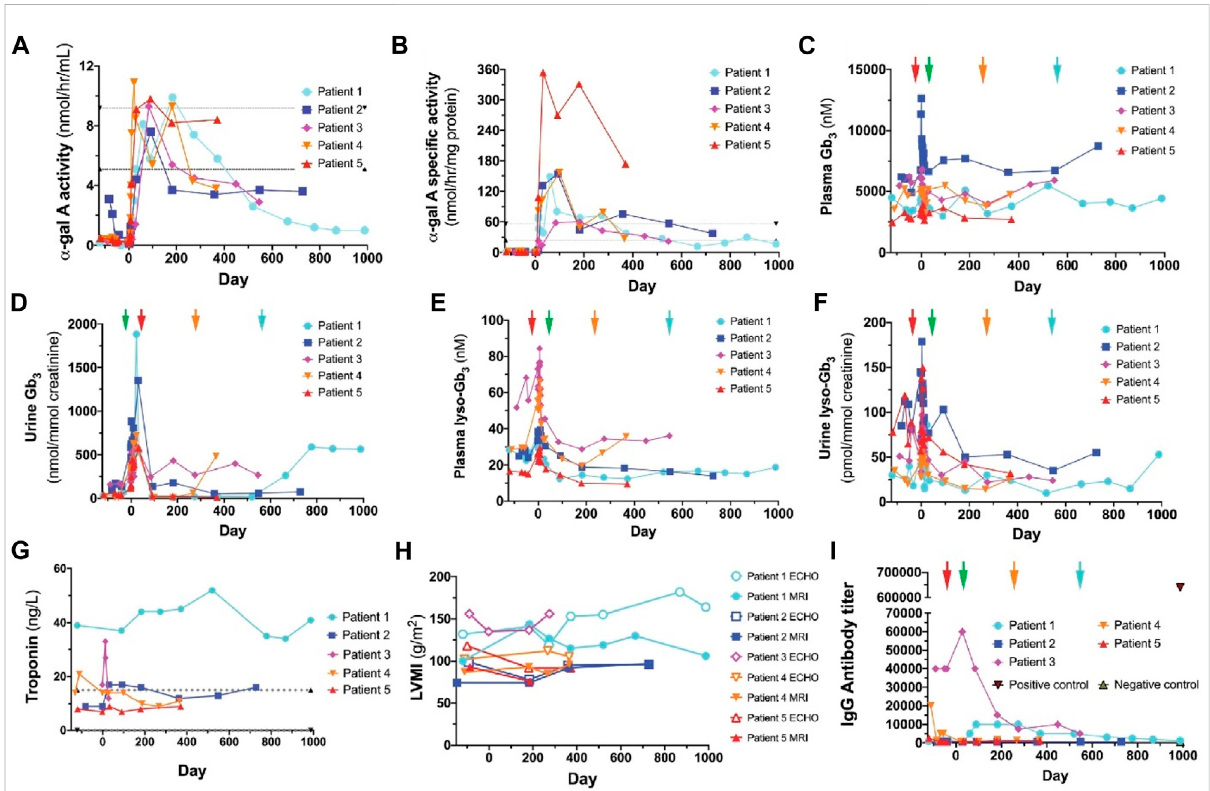
FIGURE 3 α -GLA activity in plasma (A) and leukocytes (B) of patients with Fabry disease following gene therapy. The plasma (C) and urine (D) levels of Gb3inpatientswerealteredaftertheinitiationofgenetherapy.Theplasma (E) andurine (F) levelsoflyso-Gb3werealteredaftertheinitiationofgene therapy. Detection of troponin levels (G) and left ventricular mass index (LVMI) (H) in patients. Patient three did not attend all the measurements. (I) Anti- α -GLA antibody levels were assessed in fi ve patients following viral vector-mediated therapy (Khan et al., 2021). Copyright 2021, The